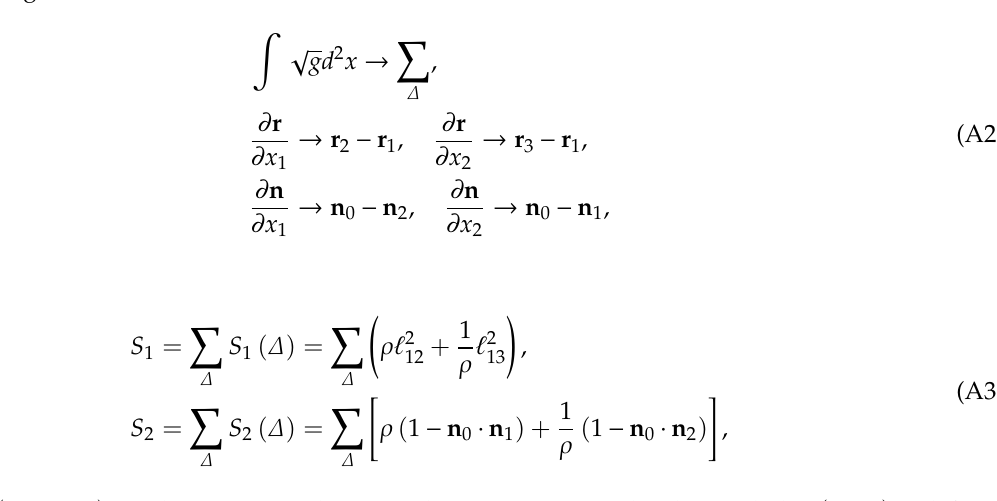
and γ 21 (cid:96) 2 of the bond 12, where (cid:96) 12 = (cid:96) 21 12 21